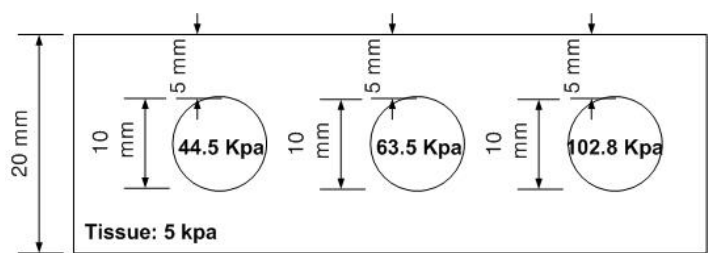
Figure 14. Schematic of the hardness phantom.